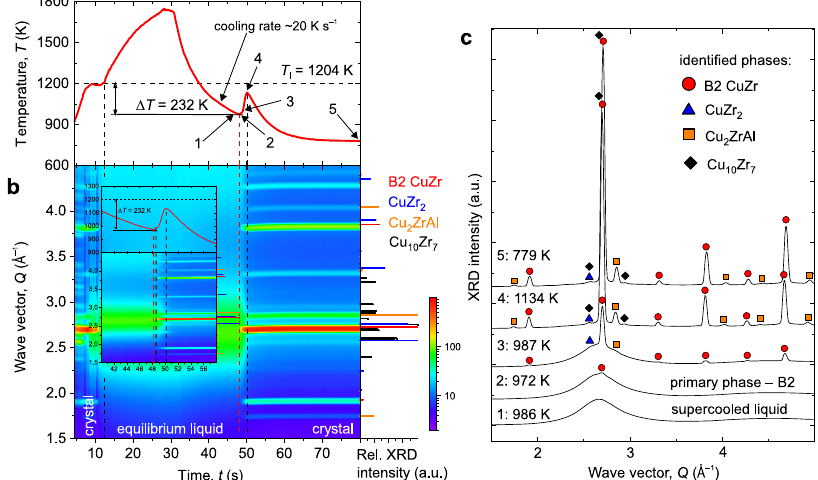
Fig. 4 In situ high-energy X-ray diffraction showing phase-formation sequence during solidi fi cation of supercooled Cu 47.5 Zr 47.5 Al 5.0 liquid in EML facility. a Temperature pro fi le showing the achieved supercooling of Δ T = 232 K = ( T l − T ); T l is the liquidus temperature. A typical cooling rate before the recalescence is ~20 K s − 1 . b The corresponding evolution of X-ray pattern measured at 5 Hz. The inset shows a close-up of the solidi fi cation process. Right- hand part: The relative XRD intensities of selected peaks normalized to the highest-intensity peak are depicted. c Selected individual XRD patterns showing the different stages of solidi fi cation on cooling. Full symbols label the position of the most pronounced peaks of the identi fi ed phases revealed by Rietveld re fi nement — details can be found in Supplementary Information, Supplementary Fig. 9. The labeled points correspond to the time of 1: 47 s; 2: 48.2 s; 3: 48.6 s; 4: 50.2 s; and 5: 80 s. Source data of the XRD patterns are provided on https://archive.materialscloud.org/ 61